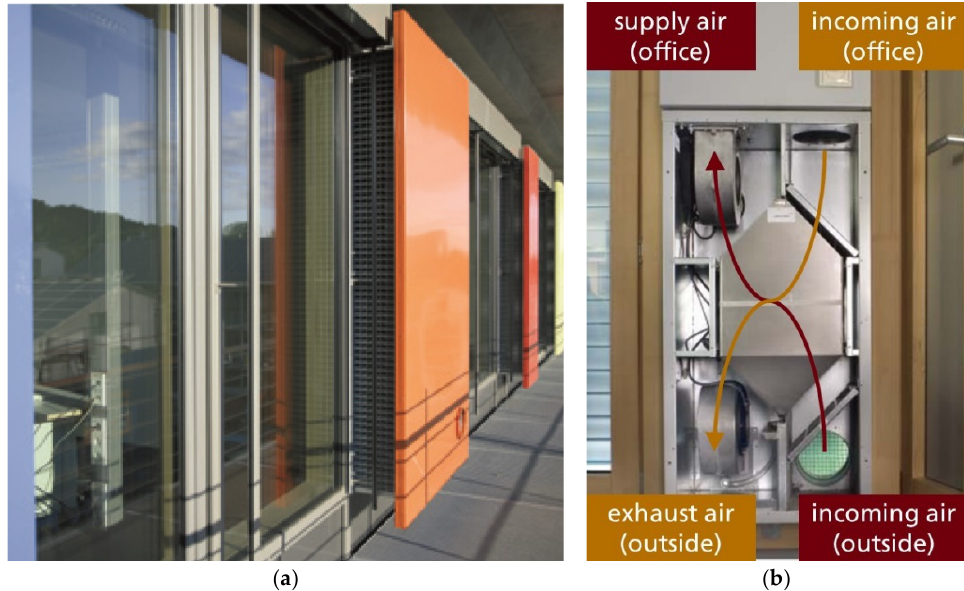
Figure 3. ( a ) Outer cover of the ventilation panel. ( b ) Wall-integrated cross-flow heat exchanger next to open ventilation panel [26].